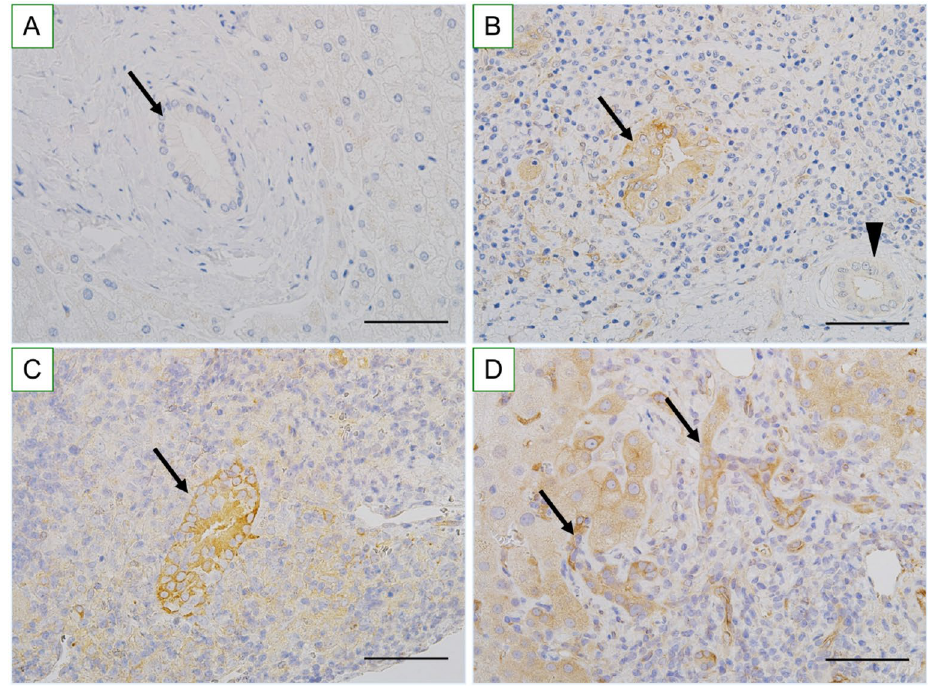
Figure 3. Increased expression of IFIT3 in small bile ducts and bile ductular cells in PBC and control livers. ( A ) IFIT3 is not expressed in small bile duct (arrow) in normal liver. ( B ) IFIT3 is expressed in biliary epithelial cells (BECs) involved in chronic nonsuppurative destructive cholangitis (arrow) in PBC. Arrowhead indicates a normal-looking small bile duct without IFIT3 expression. ( C ) Another example of IFIT3 expression in chronic nonsuppurative destructive cholangitis (arrow) in PBC. ( D ) IFIT3 is expressed in the cytoplasm of bile ductular cells in ductular reactions in PBC. Immunostaining for IFIT3. Original magnification, × 400. Scales are 50 μm.